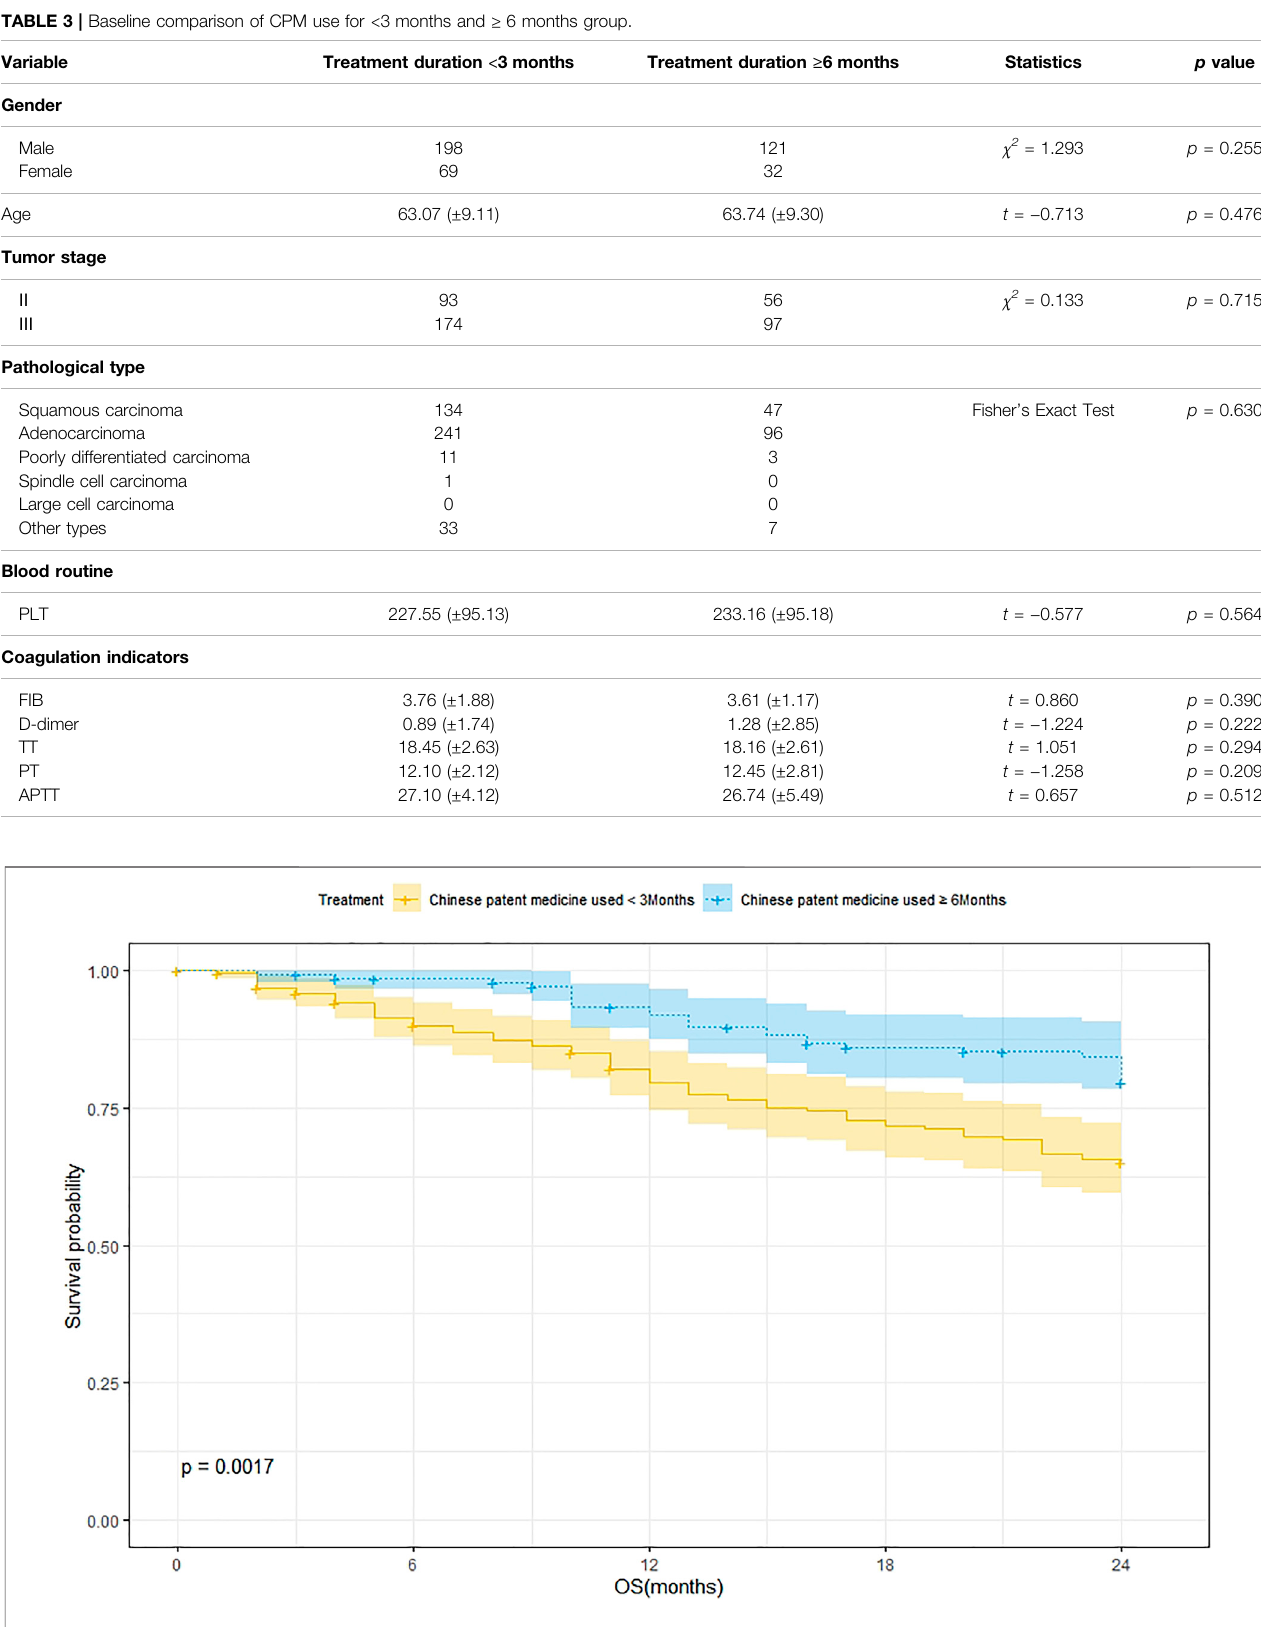
Frontiers in Pharmacology |